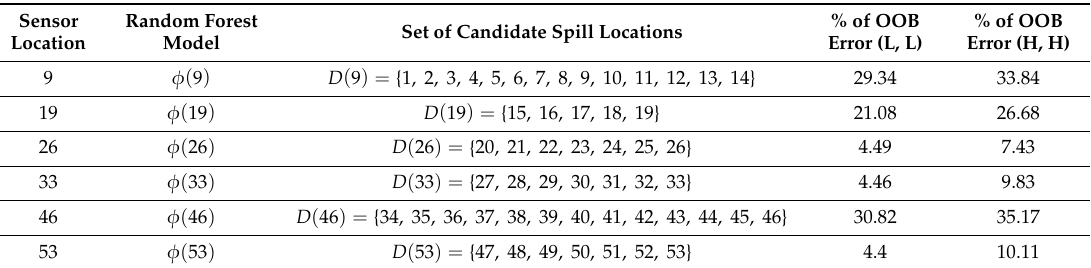
Figure 6. Targeted study area with six sensors. Table 1. Random forest models with their OOB